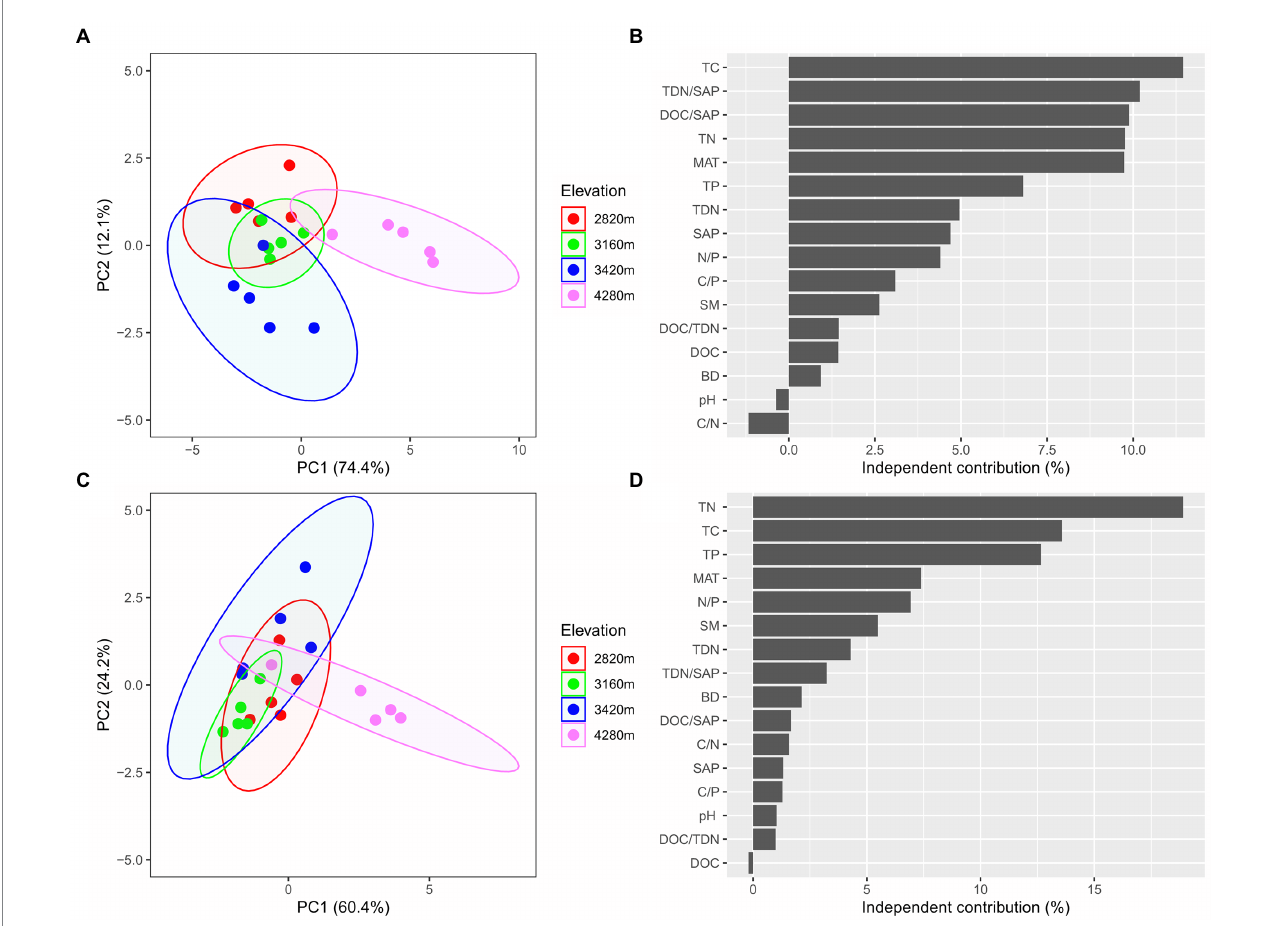
FIGURE 4 The biplots of the principal component (PCA) analysis based on microbial PLFAs (A) and based on extracellular enzyme activities (C) reveal the changes in soil microbial community composition and extracellular enzyme activity characteristics along the elevational gradient, respectively, and the independent contribution of explanatory variables (including MAT and edaphic factors) to the variations in soil microbial community composition (B) and extracellular enzyme activities (D) by the hierarchical partitioning